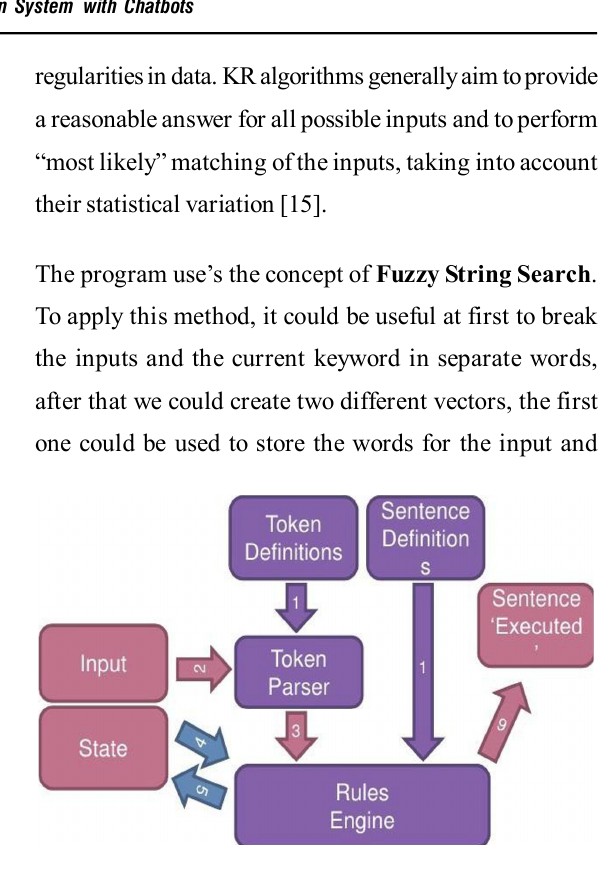
FIG. 4. A STRONGLY TYPED NLP ENGINE